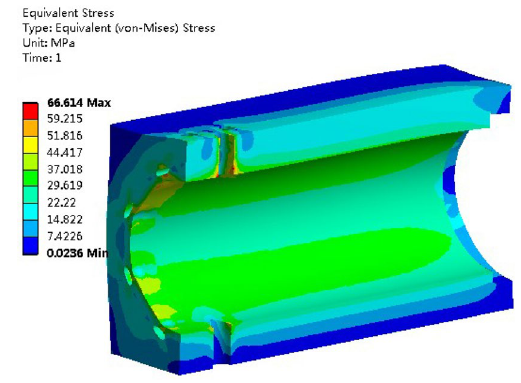
Fig. 8 Displacement variation of the piston cylinder